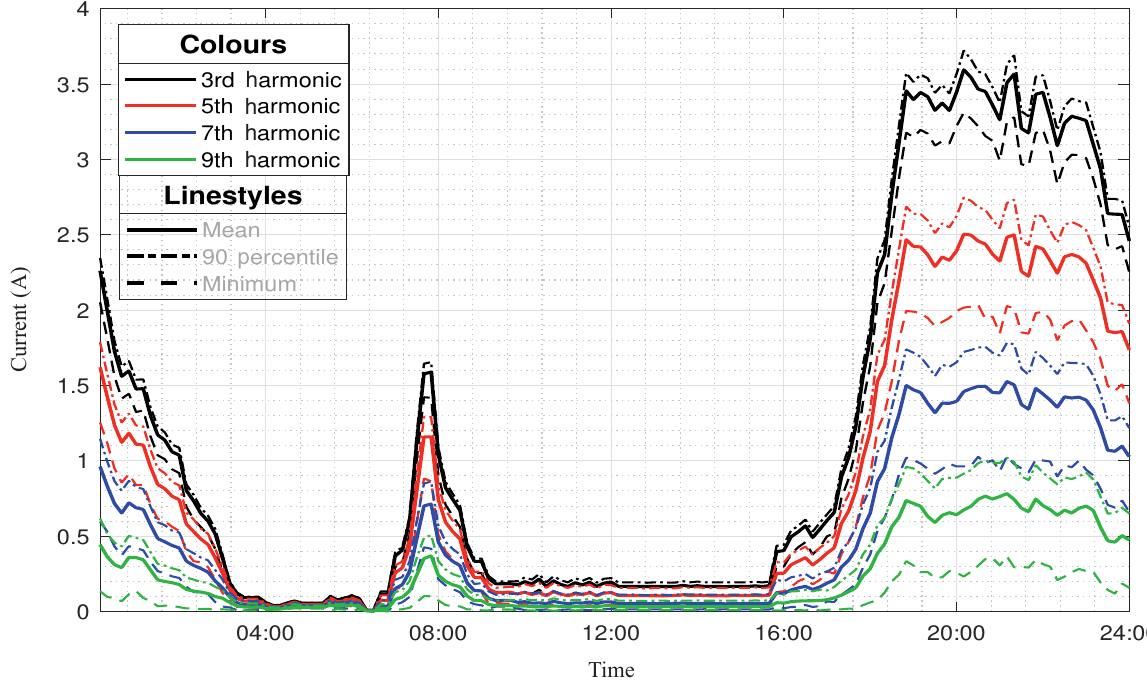
Fig. 11. Harmonic current estimation of the lighting load of 60 houses for 100